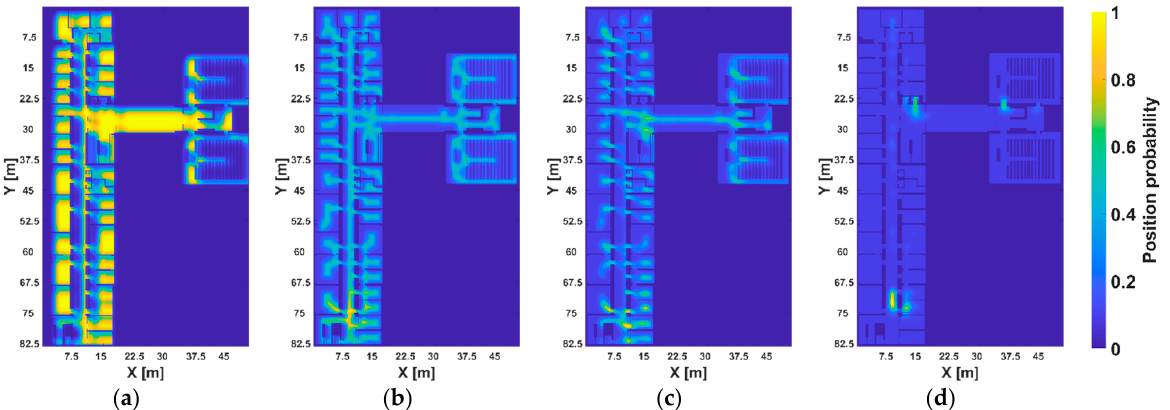
Figure 5. Resulting probability distributions: ( a ) reasoning map after five steps of only wall attenuation; ( b ) resulting probability distributions after 2, ( c ) 5, and ( d ) 20 steps.